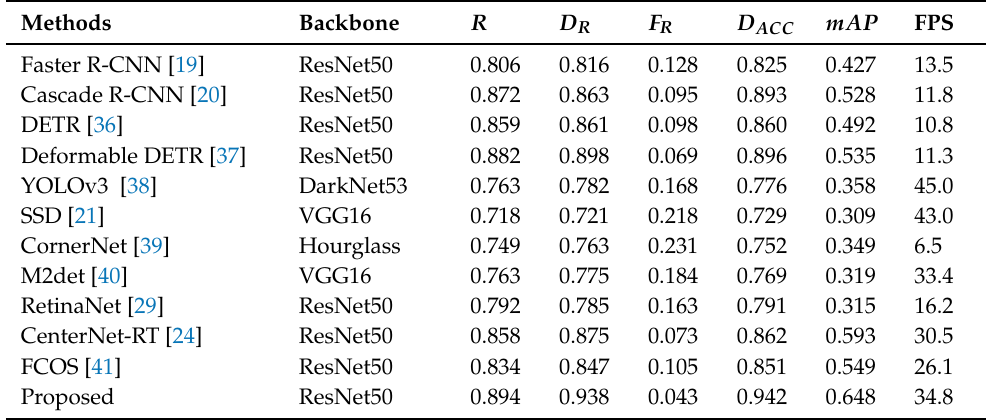
Table 4. Comparison of the speed and accuracy of different object detector on SDCFD. We compare the results with batch = 1 without using